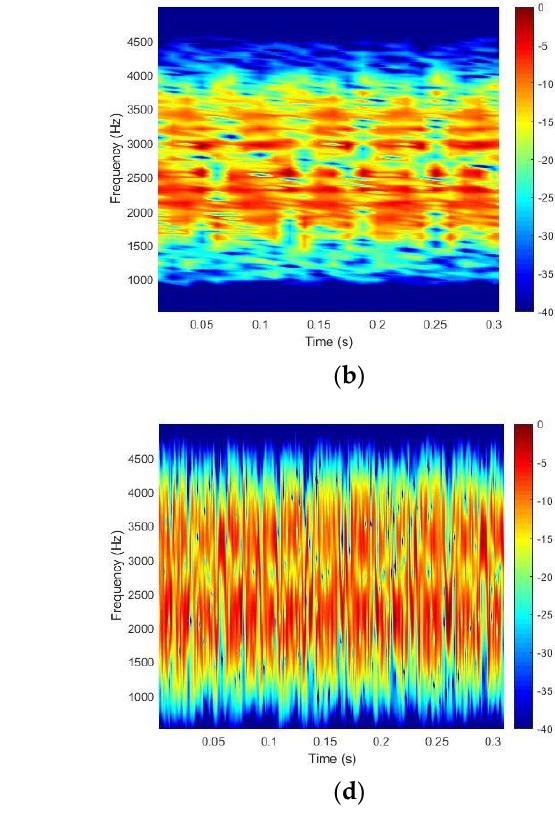
Figure 14. The spectrogram of the data: ( a ) the transmitted signal, ( b ) the received signal of the conventional CSS method, ( c ) the transmitted signal and ( d ) the received signal of the proposed GSFM method.